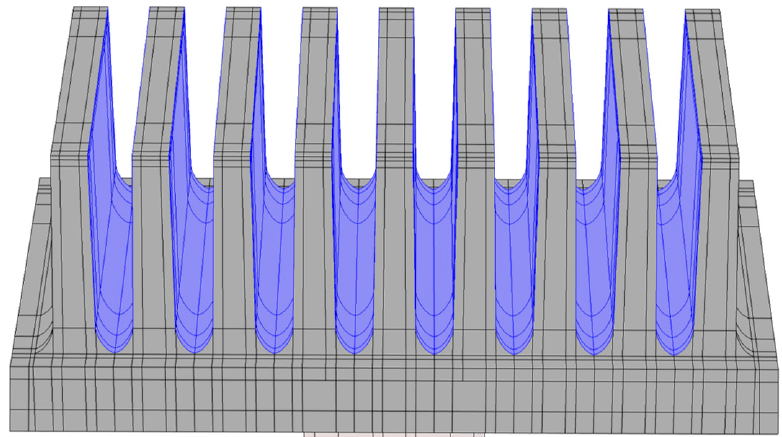
Figure 9. Fins’ surfaces (highlighted in blue) that are treated within the mutual radiation.